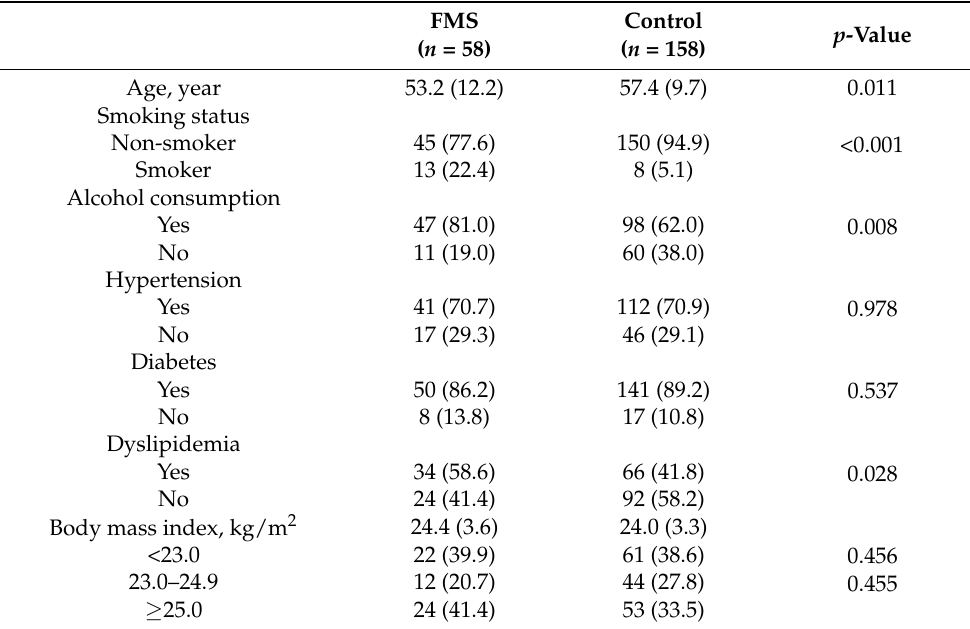
Table 1. General characteristics of study participants.